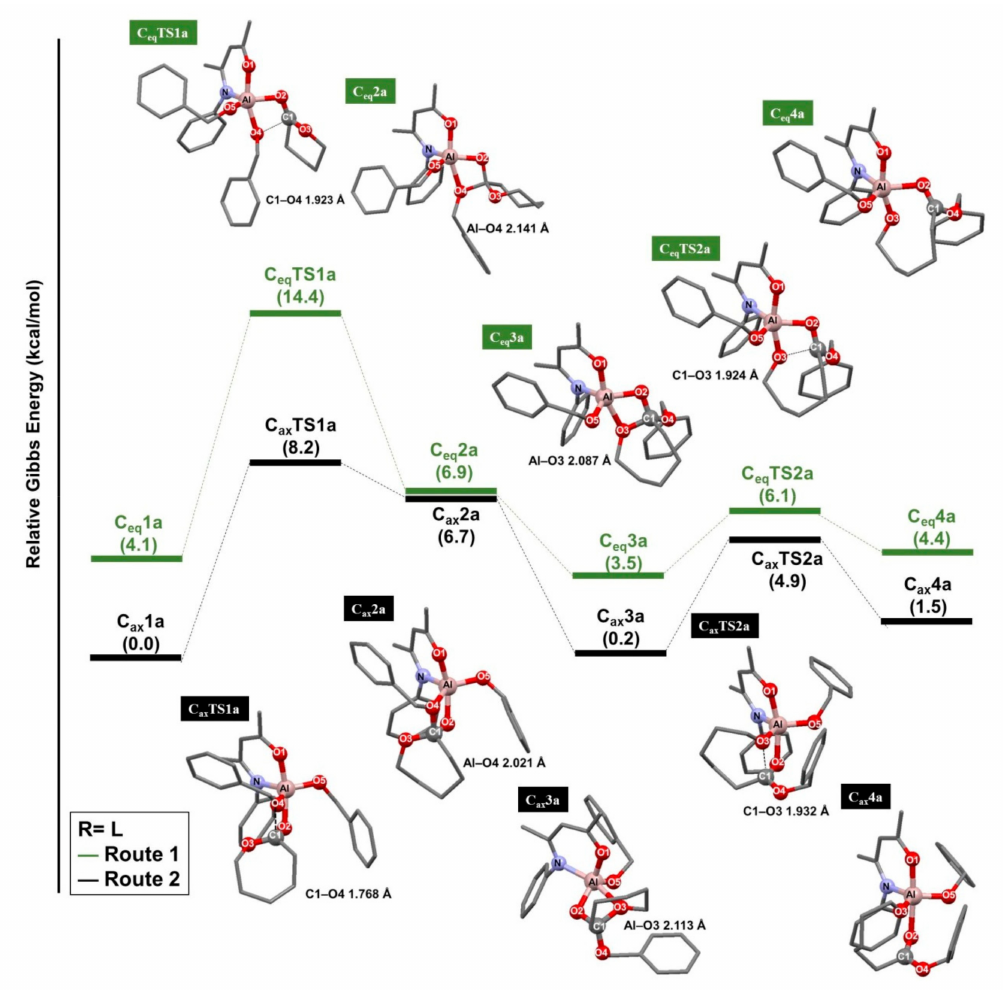
Figure 5. Reaction profile and optimized structures of the L system. (Monomer: ε